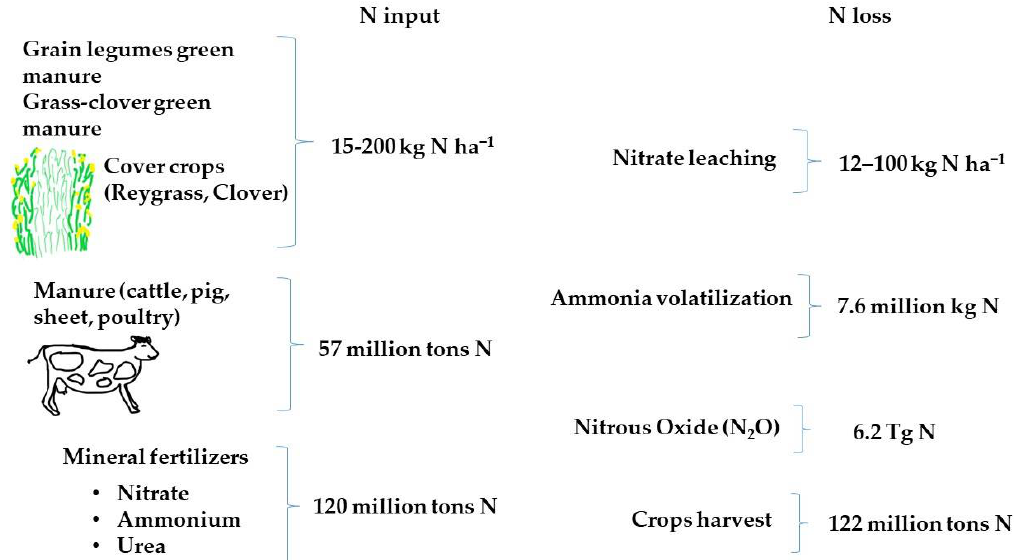
Figure 1. Values of nitrogen (N) inputs and losses through worldwide agricultural activities.N input references: [5,24,29]; N loss references: [2,5,36,61].